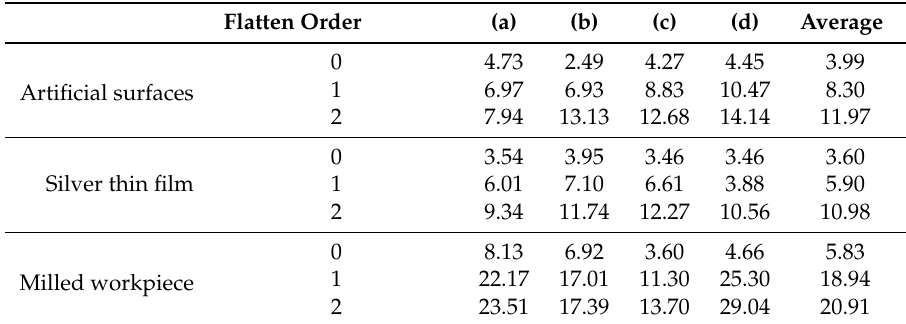
Table 1. The minimum sampling number of picture elements for the three types of surfaces and the influence of flatten order. The denotations ( a – d ) represented four different positions randomly selected on these surfaces,